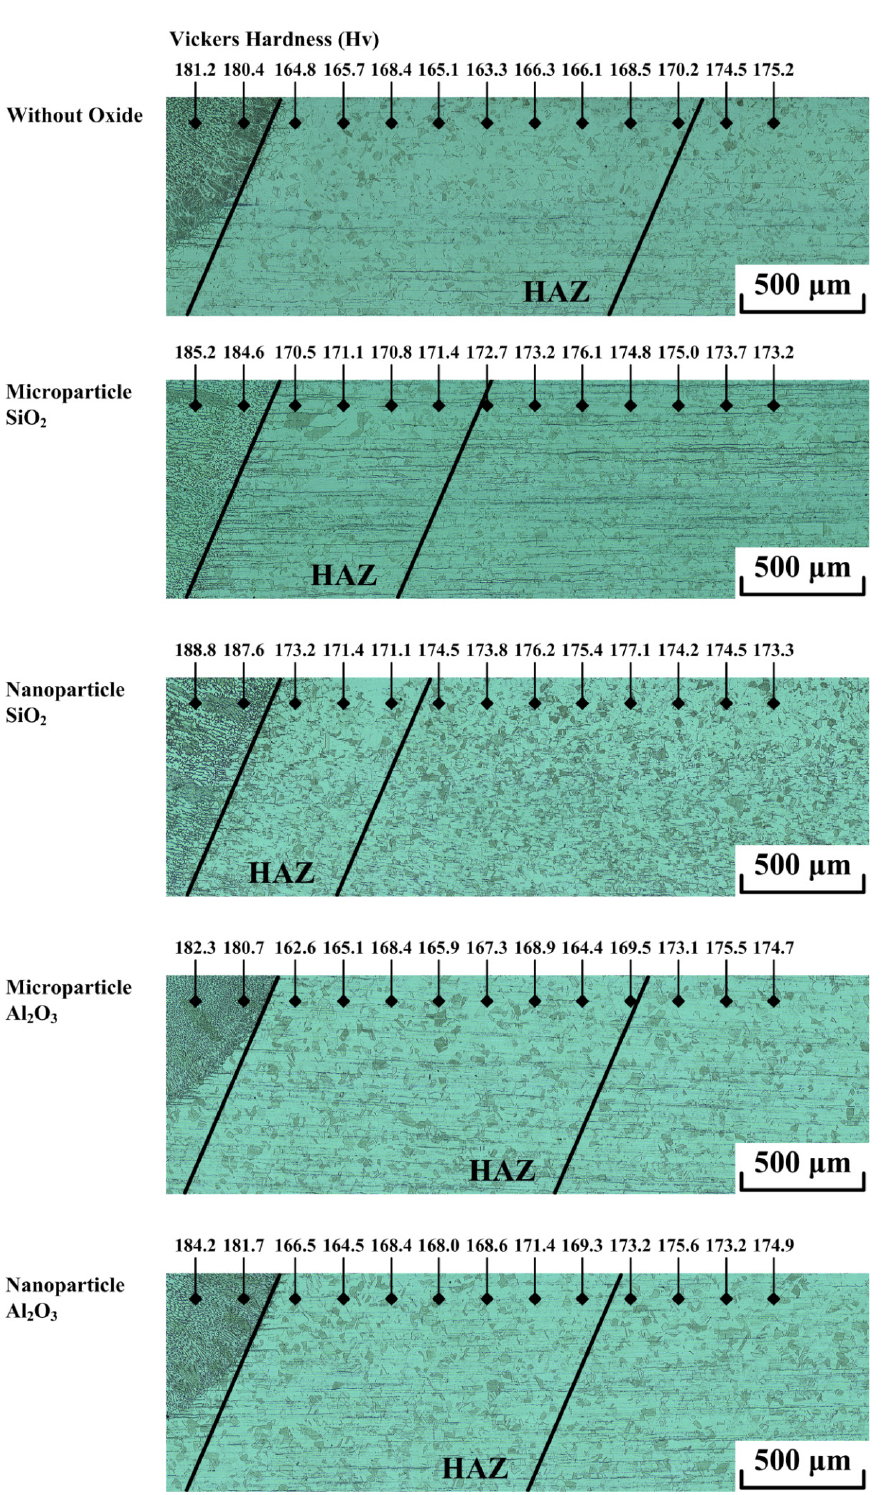
Figure 10. Hardness distribution of TIG weldments made with and without